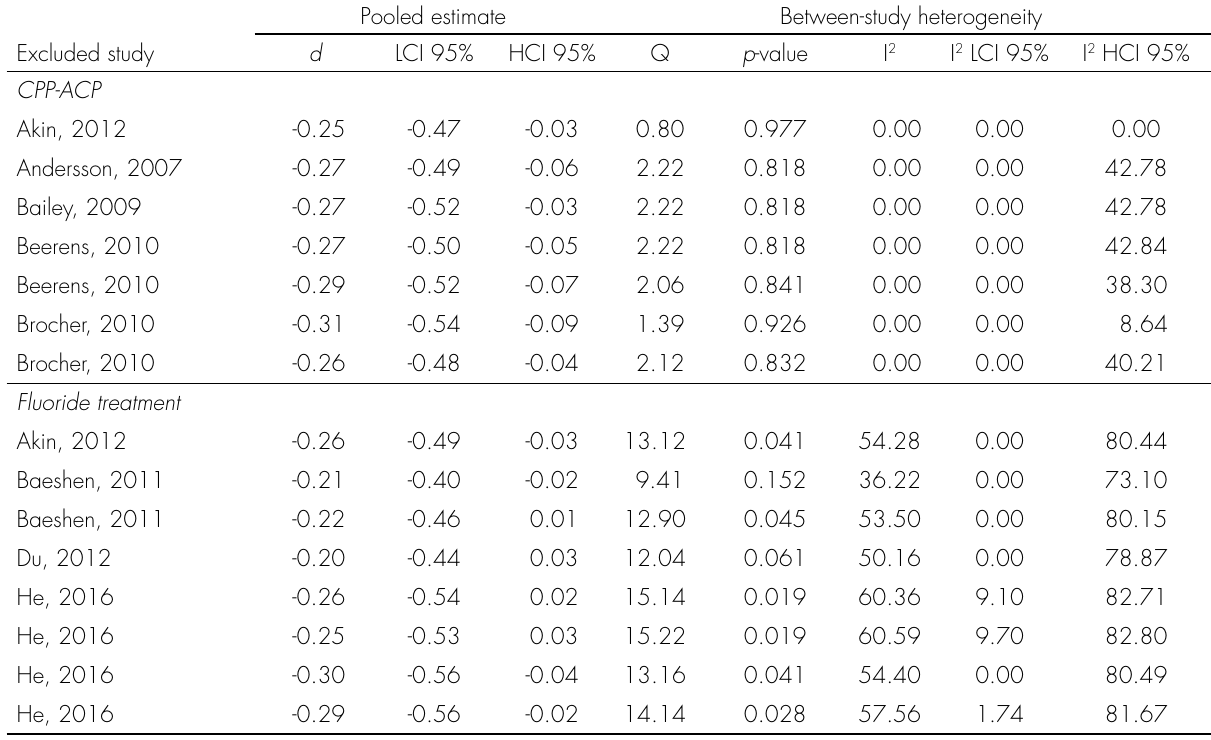
Table II. Sensitivity analysis of quality-effects meta-analysis of CPP-ACP and fluoride treatment in reducing WSL outcomes.